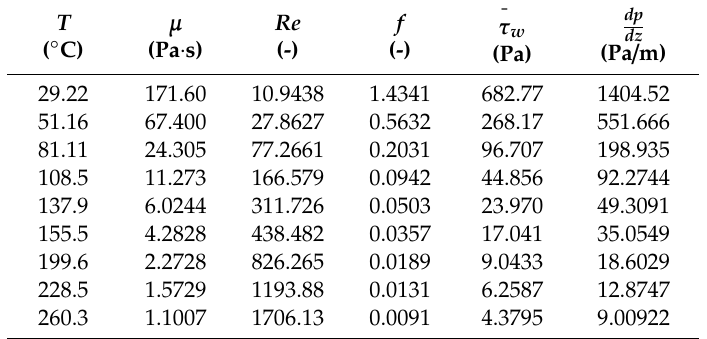
Table 5. Values of the fluid dynamic parameters obtained in the simulations with β = 0.02 and N = 12.